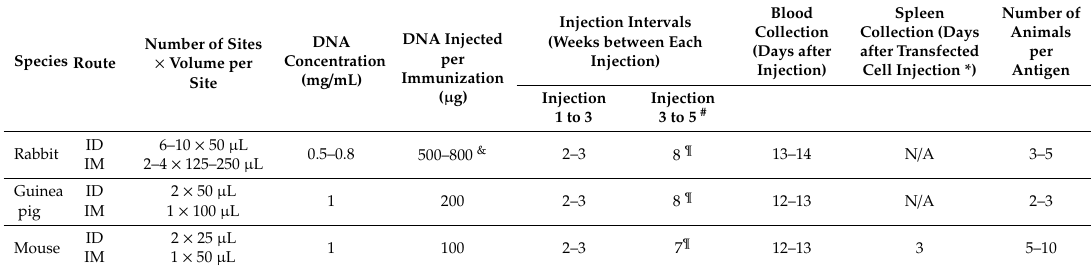
Table 3. Proposed protocol to raise polyclonal and monoclonal antibodies by cDNA immunization.